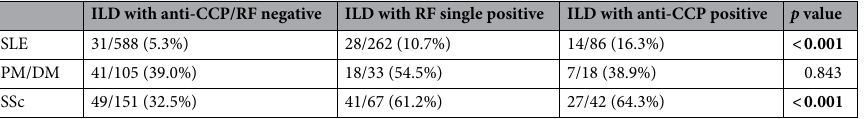
Table 2. Relationship between anti-CCP antibody/RF and interstitial lung disease in connective tissue diseases. Bold text indicates statistical significance. Values are expressed as n (%). all p values Bonferroni corrected. SLE, systemic lupus erythematous; PM, polymyositis; DM, dermatomyositis; SSc, systemic sclerosis; ILD, interstitial lung disease.